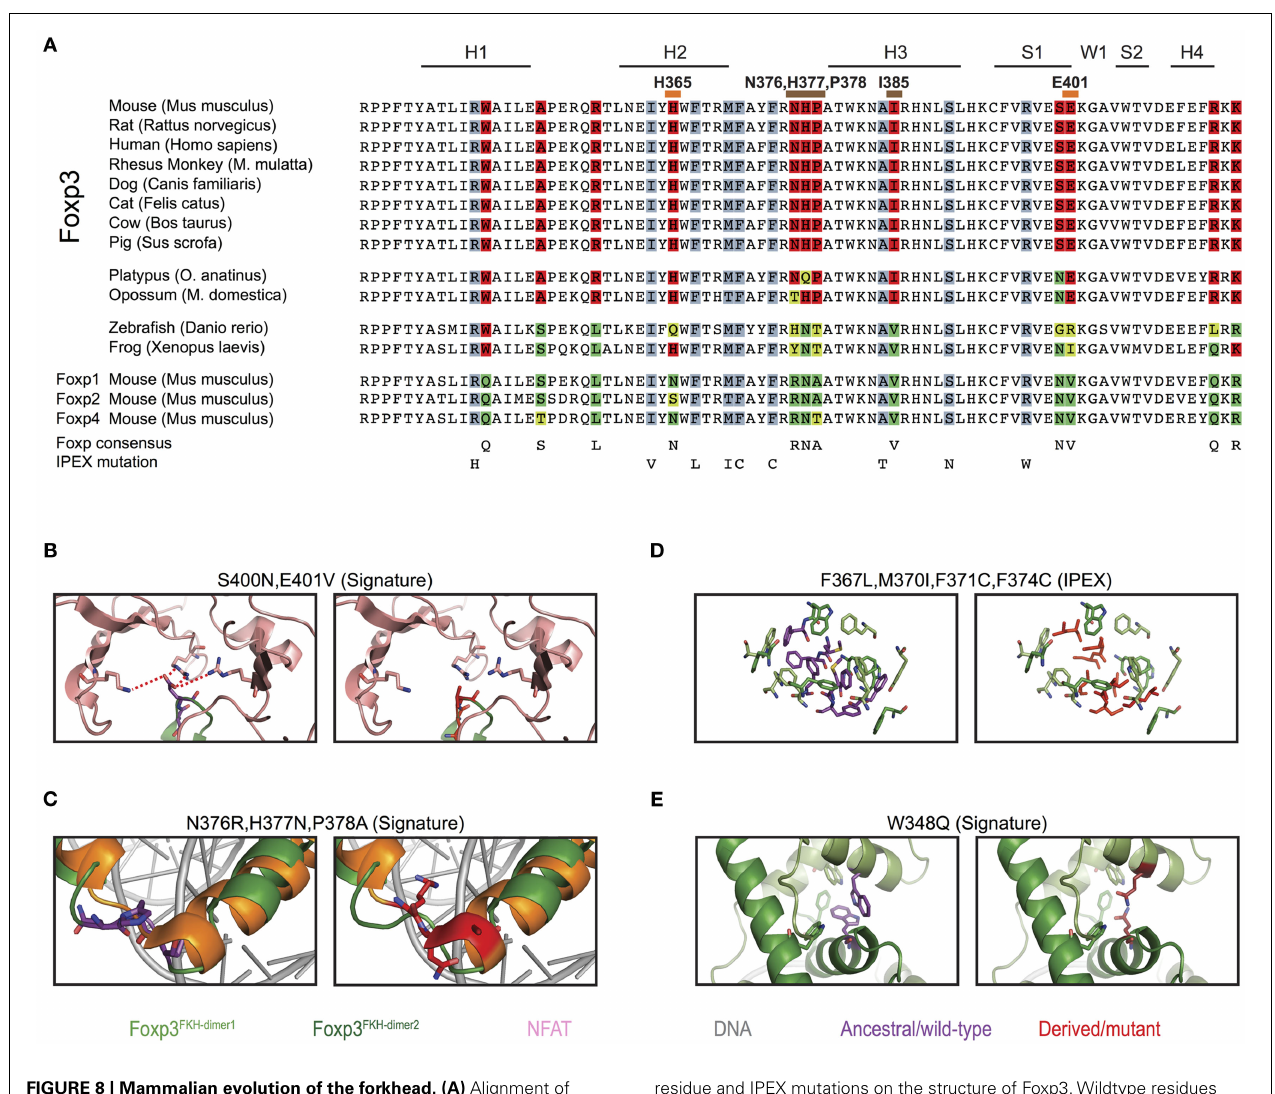
FIGURE 8 | Mammalian evolution of the forkhead. (A) Alignment of Foxp subfamily FKH domains. Foxp3-specific signature residues are highlighted in red, whereas those of other Foxp subfamilies are highlighted in shades of green. IPEX mutations are underlaid in blue. Signature residues predicted to be involved in NFAT interaction or to affect DNA binding are marked with orange and brown lines respectively (H, helix; S, β -sheet;W, wing). (B–E) Predicted effects of signature